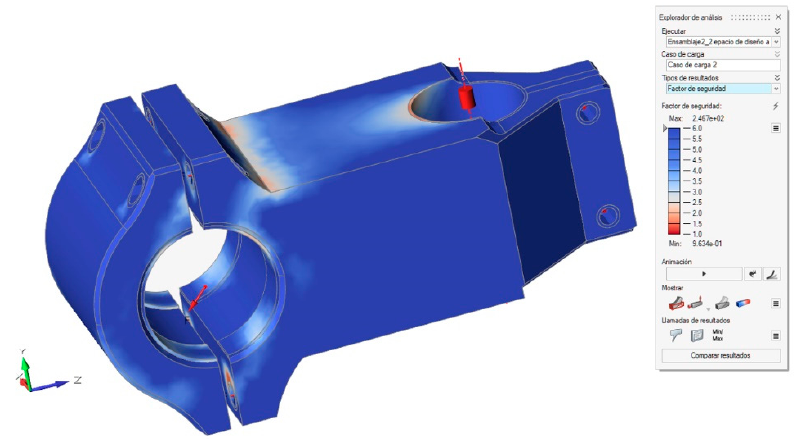
Figure 6. Result of the finite elements analysis expressed as safety factors of the part using the Inspire™ tool.